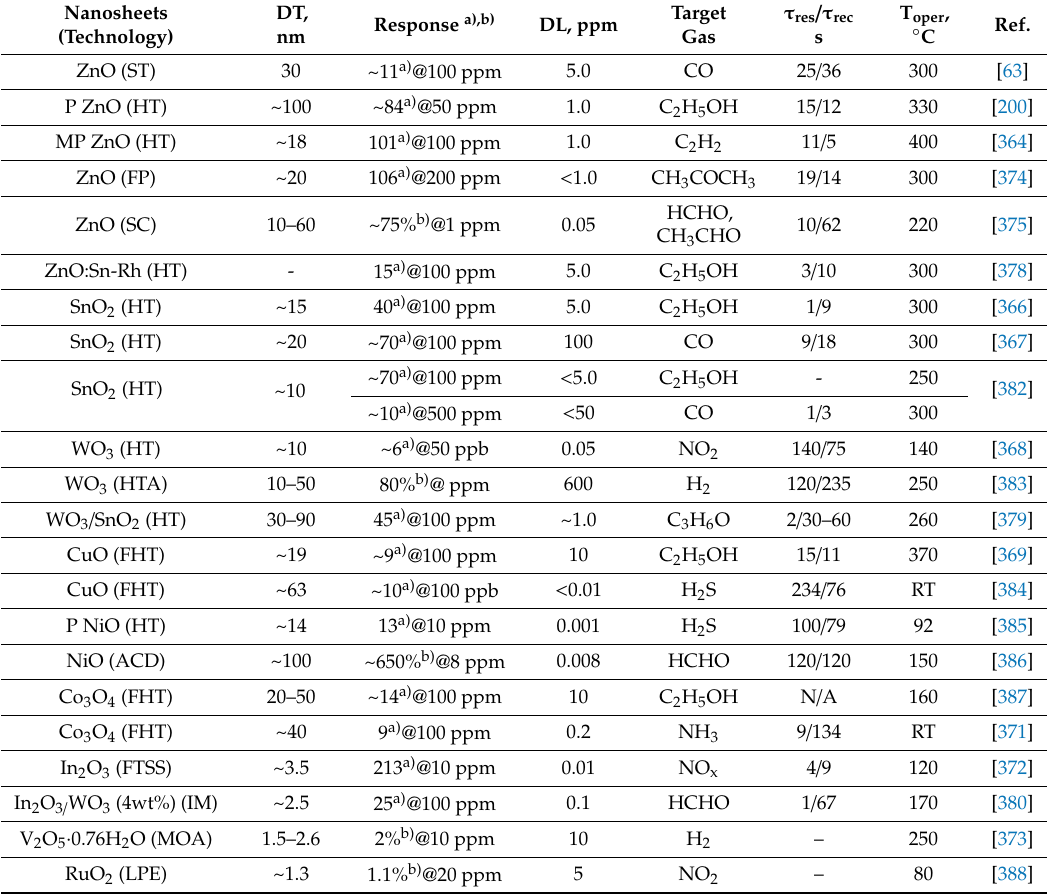
Table 4. Parameters of gas sensors based on 2D metal oxide